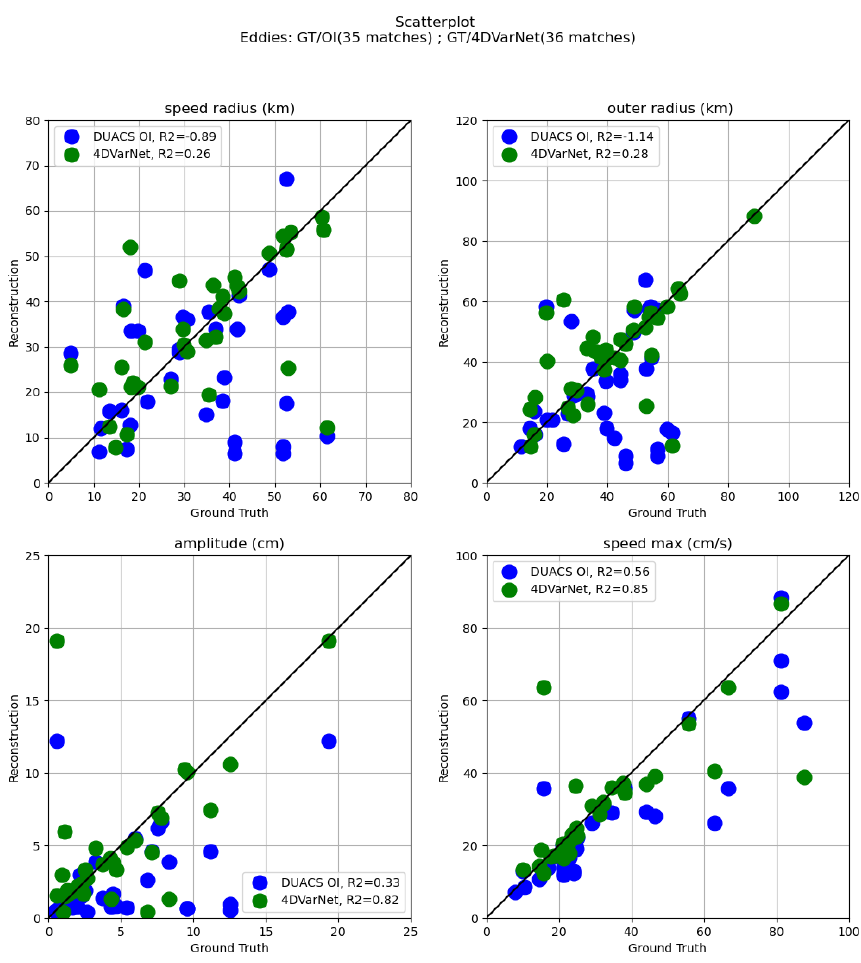
Figure 11. Speed radius (km), outer radius (km), amplitude (cm), and speed max (cms − 1 ) scatterplots of 4DVarNet/DUACS OI (one SWOT plus four nadirs) vs. ground truth in the GULFSTREAM domain (25 October 2012) for matching